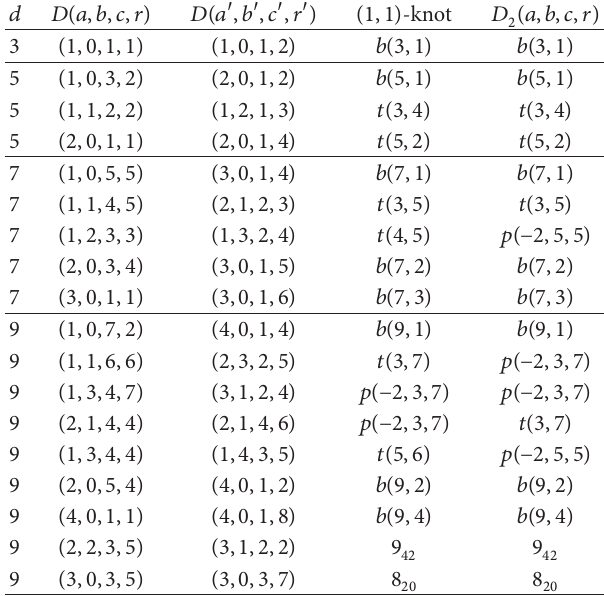
Table 1: 𝐷(𝑎,𝑏, 𝑐, 𝑟) and 𝐷(𝑎 󸀠 , 𝑏 󸀠 , 𝑐 󸀠 , 𝑟 󸀠 )